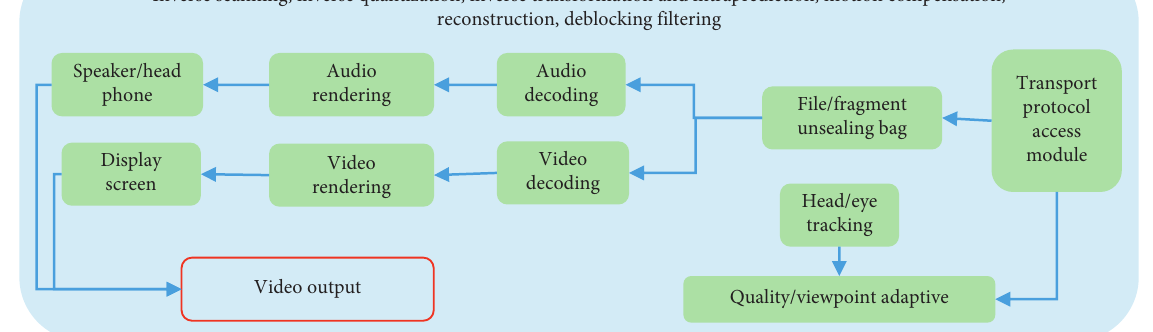
Figure 2: Virtual reality video processing